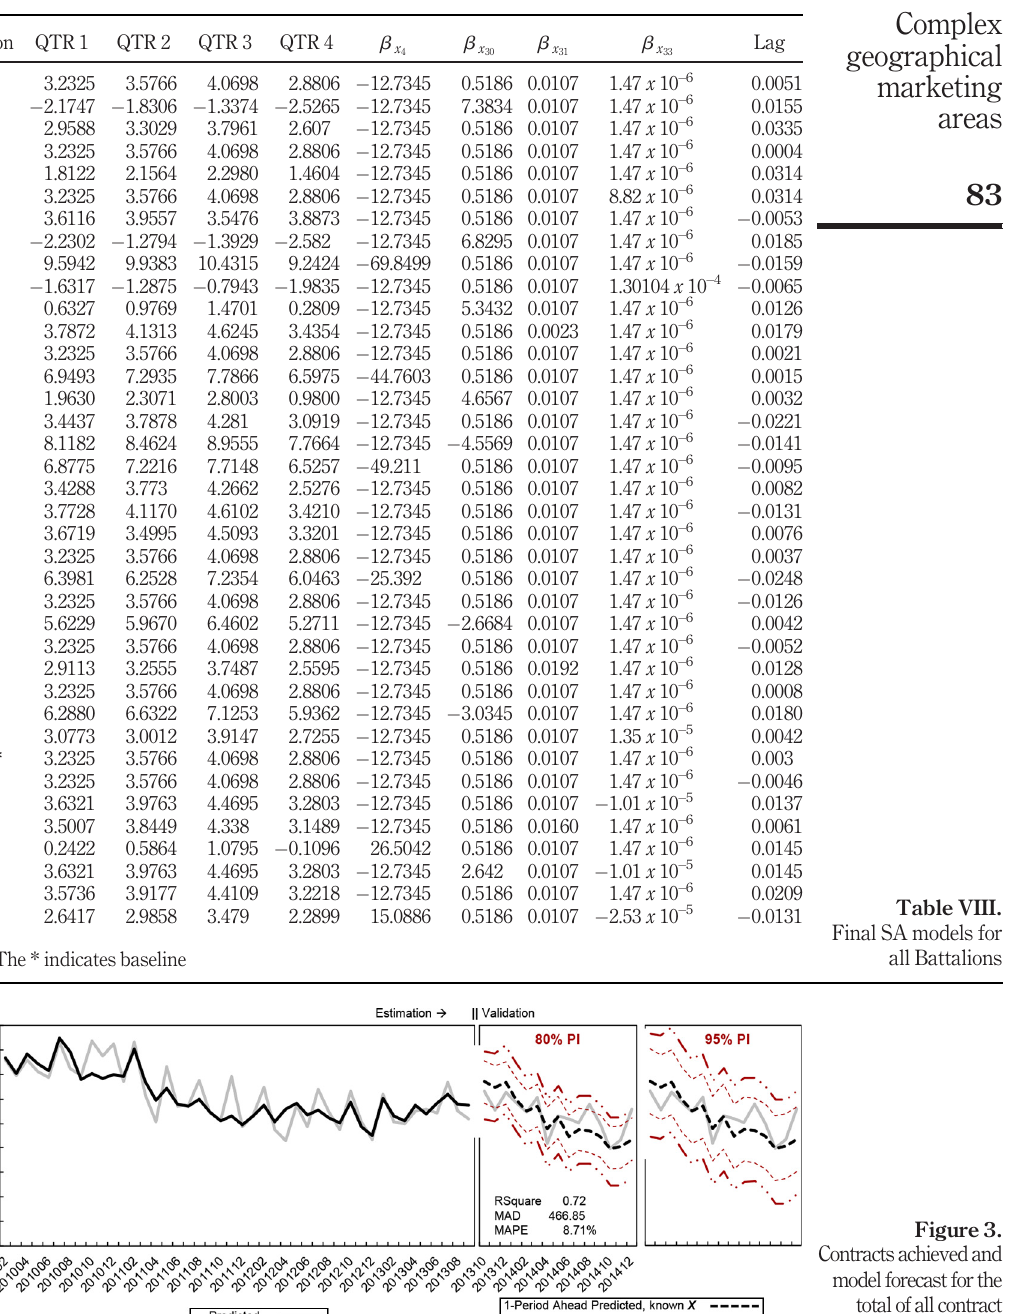
Figure 3. Contractsachievedand modelforecastforthe totalofallcontract